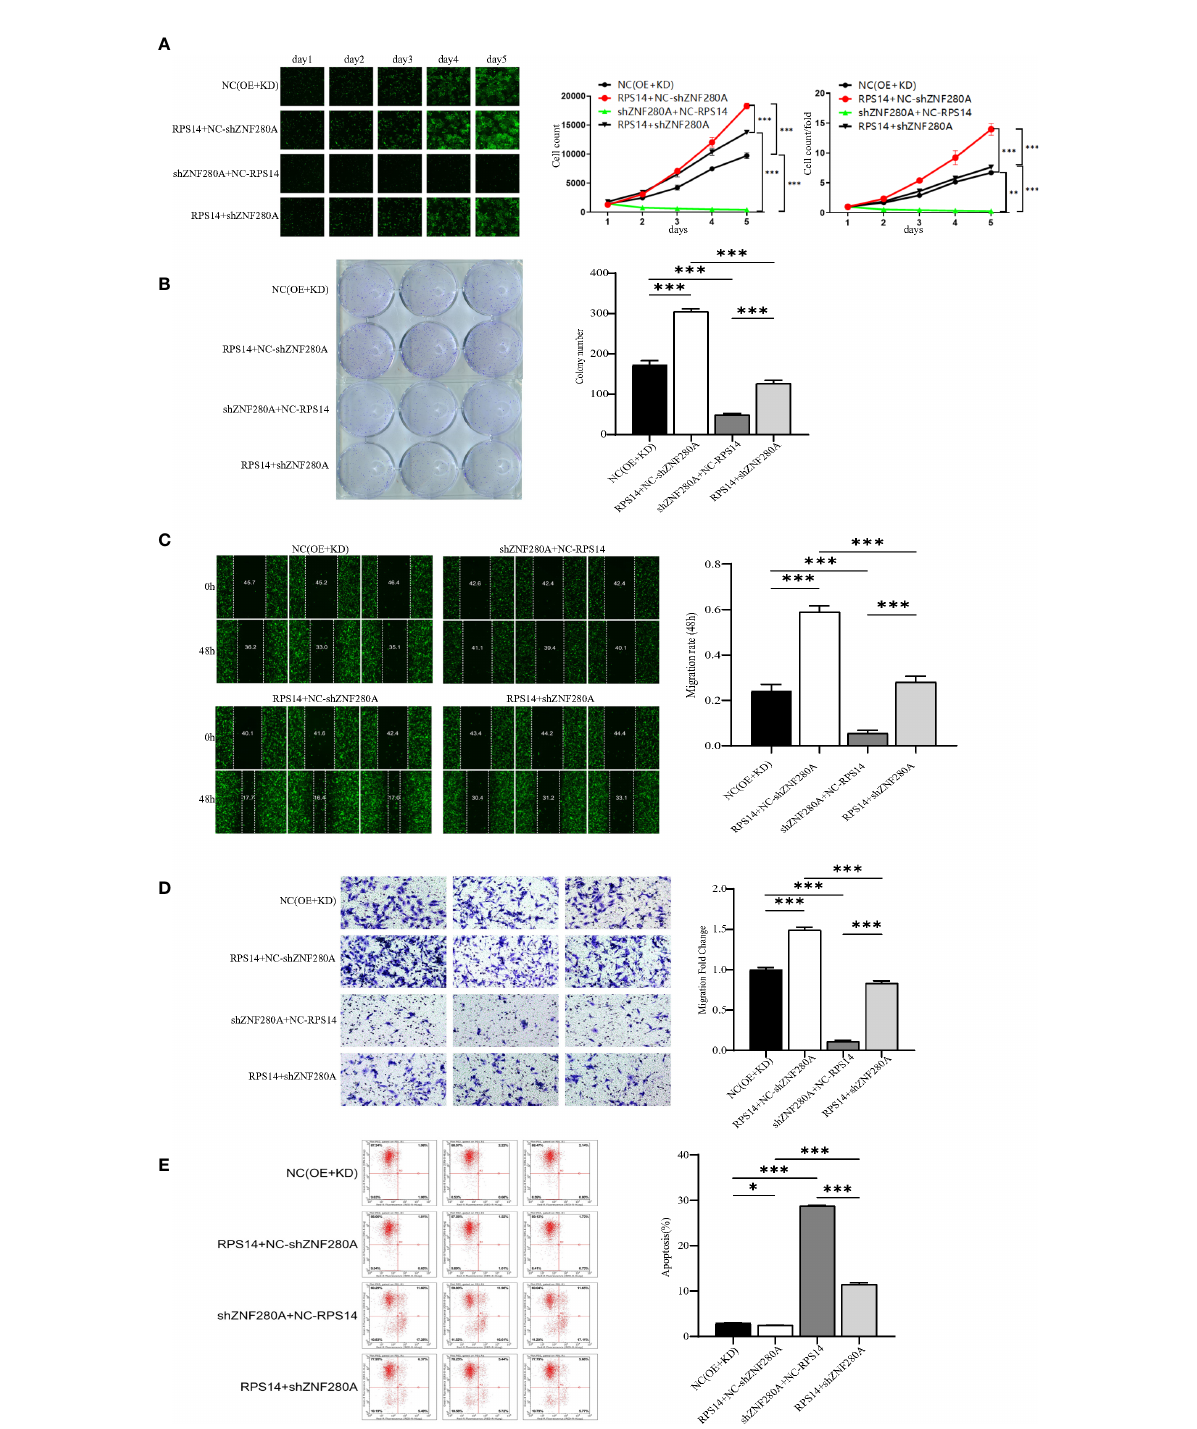
FIGURE 5 ZNF280A knockdown alleviates RPS14 overexpression induced promotion of CRC (A – E) RKO cells transfected by NC (OE+KD), RPS14 overexpression lentivirus, ZNF280A knockdown lentivirus, and simultaneous RPS14 overexpression and ZNF280A knockdown lentivirus were subject to the detection of cell proliferation by Celigo cell counting assay (A) , colony formation (B) , cell migration by wound-healing assay (C) and cell migration by Transwell assay (D) , and cell apoptosis by fl ow cytometry (E) . The representative images were selected from at least three independent experiments. Data were shown as mean ± SD. *P<0.05, **P<0.01,